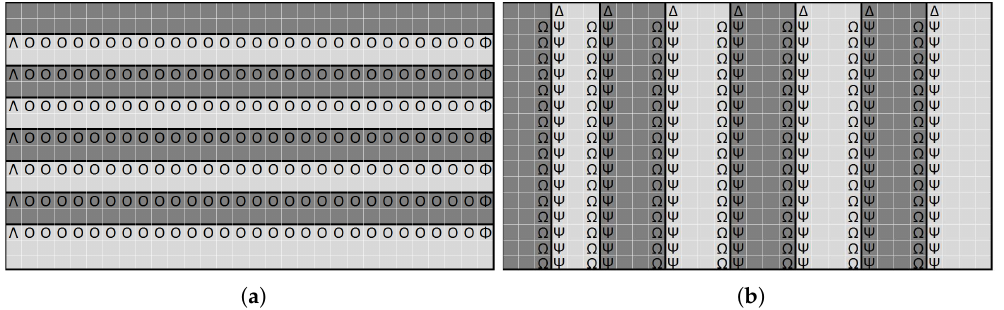
Figure 7. Marked CTUs with the coding affected, in column and row tile layouts for the partitioning of a Full HD frame into 8 tiles. ( a ) 1 × 8; ( b ) 8 ×